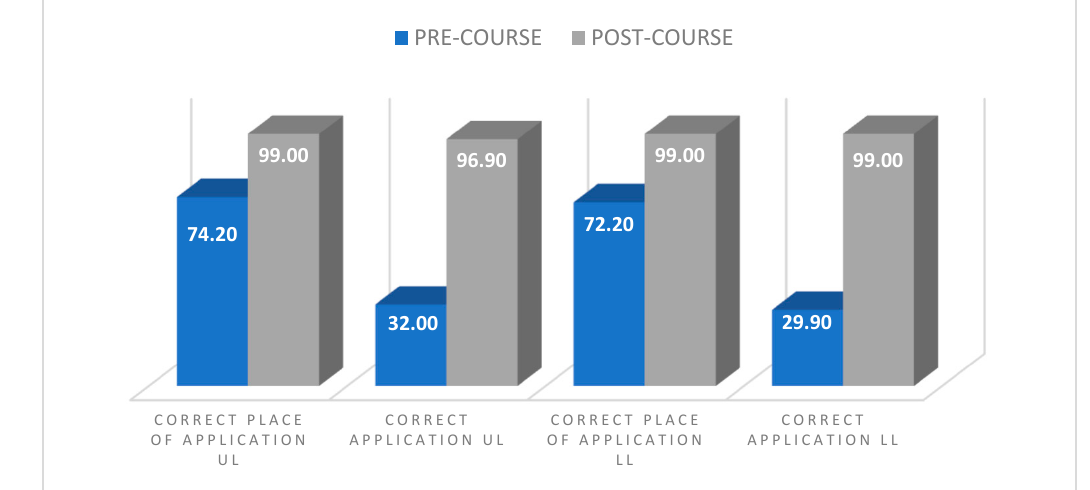
Figure 1. The percentage of results reported as “YES” is expressed.